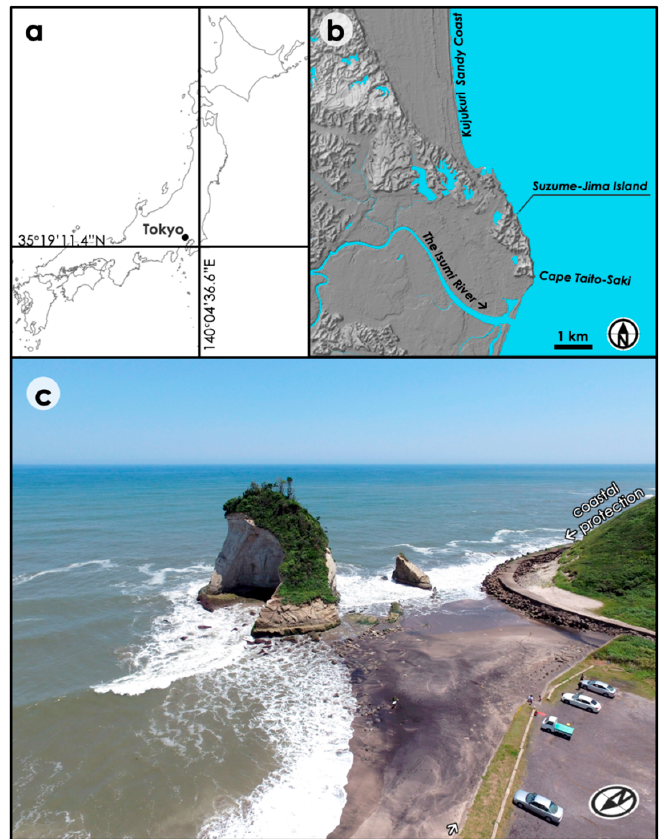
Figure 1. Study site: the Suzume-Jima island. ( a ) Overview map; ( b ) hillshade image around the study site. The Kujukuri Sandy Coast continues to the north for 66 km, whereas the rocky coasts appear in the southern side; ( c ) the aerial view of the Suzume-Jima Island (taken on 18 June 2016). Note that the island is located outside of the protection along the coast.